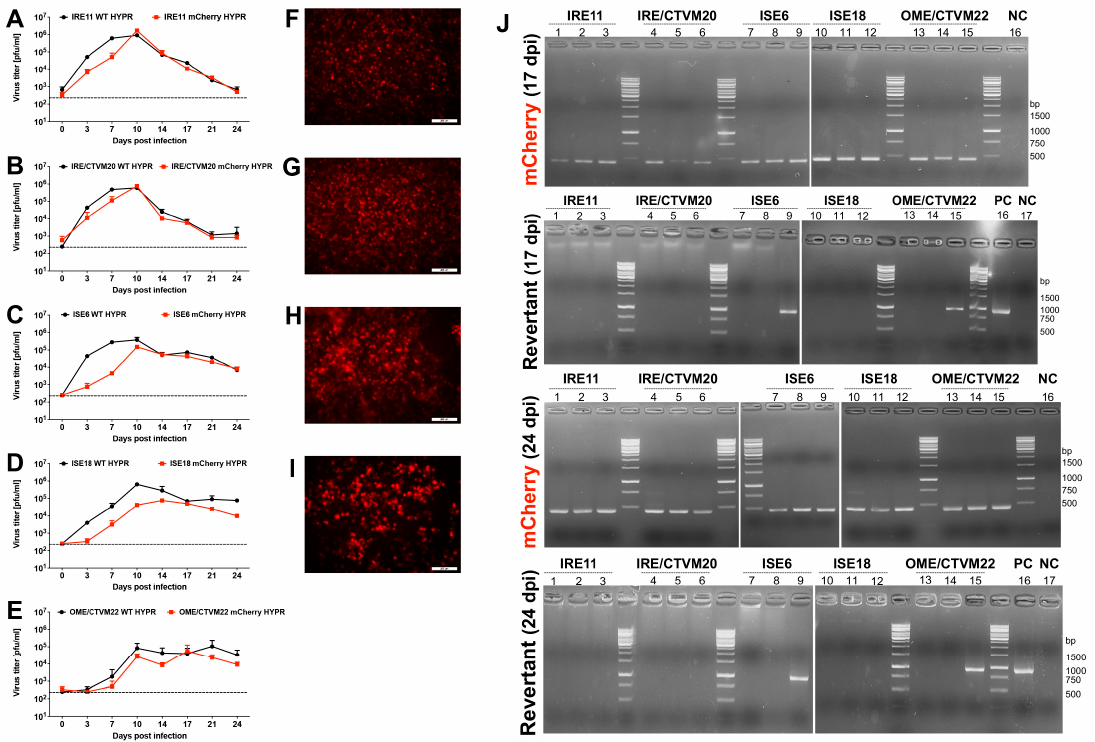
Figure 2. Characterization of mCherry Hypr in tick cell lines. Live cell imaging and growth kinetics of WT Hypr and mCherry Hypr were examined in IRE11 ( A , F ); IRE/CTVM20 ( B , G ); ISE6 ( C , H ); ISE18 ( D , I ); and OME/CTVM22 ( E ) cells using MOIs of 0.01. Cell culture medium was sampled from the wells at the indicated time points and used for plaque assay to generate growth curves ( A – E ). The mCherry expression in the infected cells was also visualized by live cell imaging ( F – I ). Viral RNA from the supernatant of infected cells at 17 and 24 dpi was isolated (n = 3) and used for RT-PCR to amplify the partial sequence of the C gene containing the mCherry gene and the wild-type variant (revertant) of the C gene ( J ), as described in the Materials and Methods. PC = positive control, NC = no template